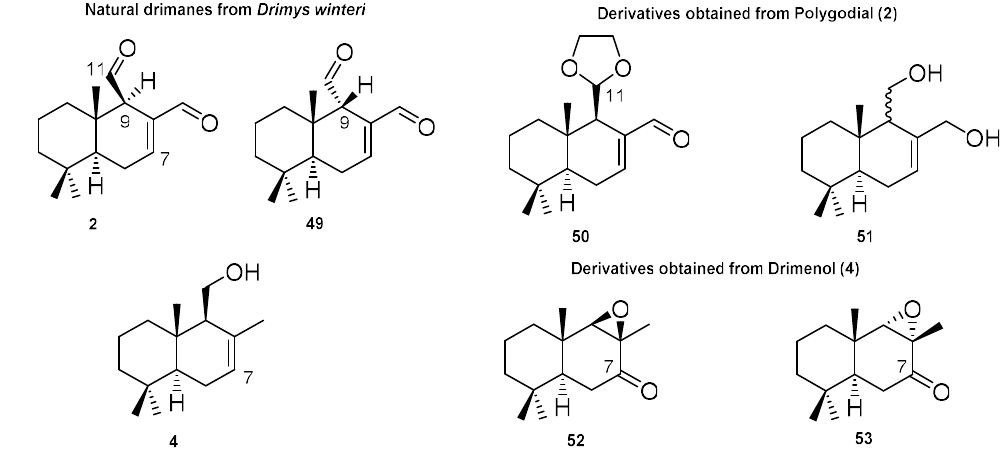
Figure 14. Cytotoxic and inactive drimanes from Montenegro et al. [64]. All derivatives were evaluated against human prostate cell lines DU-145 and PC-3 as well as the breast cancer cell line MCF-7. An increased cytotoxicity was observed for polygodial ( 2 ) and the semi-synthetic derivatives 50 , 52 , and 53 . These data allow a more systematic insight into the structure–activity relationships of drimanes. The electrophilic position at the C7 position and the configuration of the C9 position are critical for cytotoxic activity. Reduction of both aldehyde groups of polygodial ( 2 ) leads to complete inactiva- tion of both epimers of 51 . Interestingly, acetalization of the C11 aldehyde group of 2 as to 50 has no impact on cytotoxic activity. However, it can be assumed that the acetal group of 50 is converted to 2 under aqueous conditions. Furthermore, 9-epipolygodial ( 49 ) showed no cytotoxicity suggesting a critical role in the configuration of the C9 position. Transforming the C7 position of drimenol ( 4 ) to an electrophilic keto group ( 52 and 53 ) leads to cytotoxic activity compared to 4 . Dasari et al. modified polygodial ( 2 ) to increase its antiproliferative activity against A549-, Sk-Mel28, MCF-7-, U373-, and Hs683 cancer cells [65]. 9-epipolygodial ( 49 ) was obtained by an epimerization reaction of polygodial ( 2 ) (Scheme 1). Typical GI 50 values of 49 were at 2–6 µM and are 10-to-20-fold smaller than GI 50 values of polygodial ( 2 ) Thus, contradictory to Montenegro et al. (Table 2), 9-epipolygodial ( 49 ) displayed a high anti- proliferative activity [64]. Certainly, the impact of anticancer agents is cell line dependent- but even for the same cancer cell line MCF-7, both groups obtained contrary results [64,65]. The two groups performed different cell viability assays and control culture treat- ments to measure the cytostatic effects of 49 which might lead to different results. Dasari et al. measured the cell viability as sextuplicate in only one experiment [65]. On the other side, Montenegro et al. performed three independent experiments in triplicates [64]. Dis- crepancies in the data could therefore be due to the lack of biological replicates. Despite that, 9-epipolygodial ( 49 ) also showed antiproliferative effects against the multi-resistant uterus cancer cell lines MES-SA and MES-SA/Dx5, which were measured in two inde- pendent experiments. The effects are comparable to the chemotherapeutics paclitaxel and vinblastine.